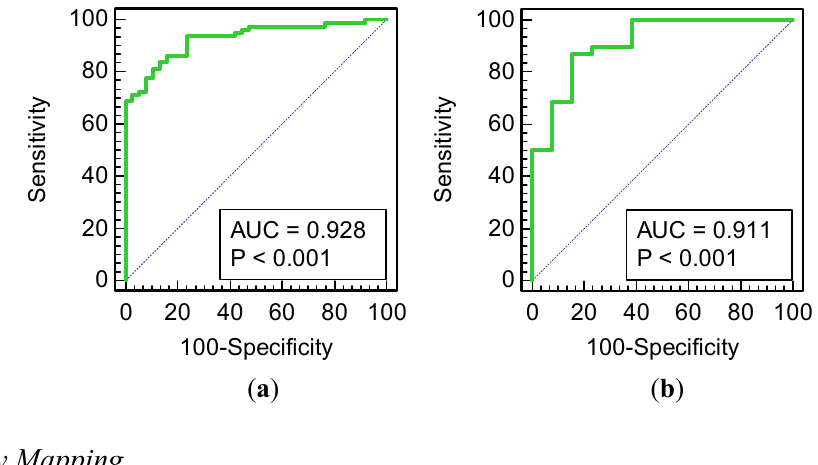
Figure 6. ROC curves and AUC values of the regression model. Fitted ROC curve in green. Dashed line for an uninformative test (sensitivity + specificity = 1). ( a ) ROC Training Dataset; ( b ) ROC Validation